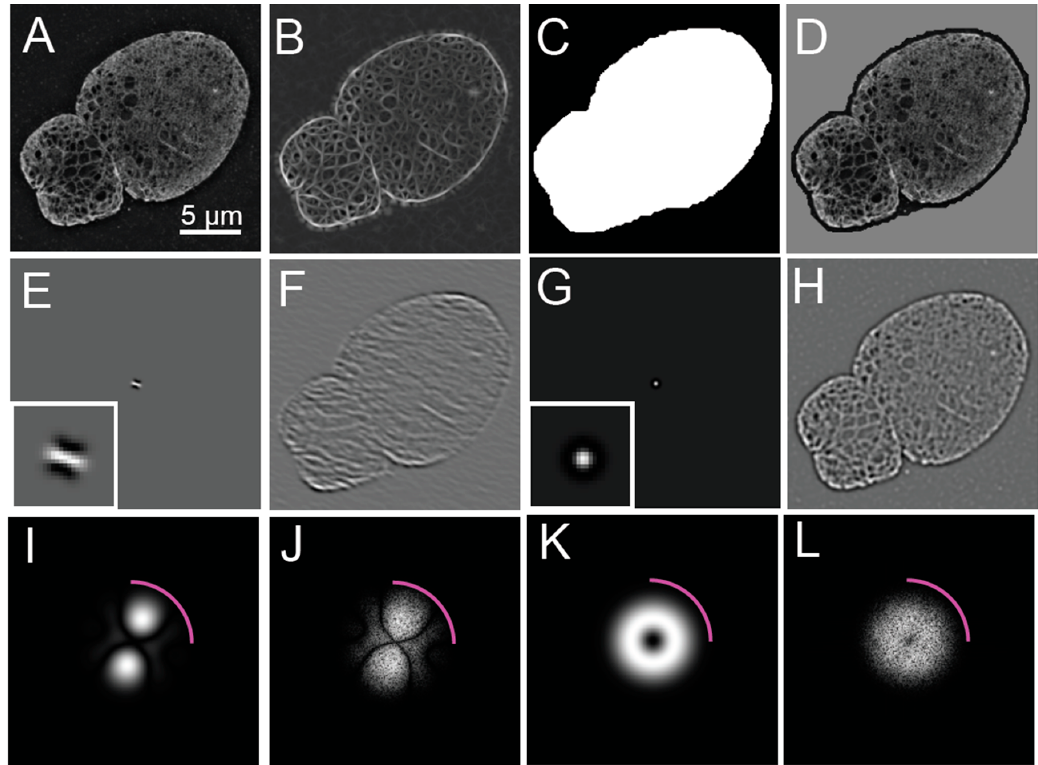
Figure 2. Steerable Filter Properties and Initial Application to a Reconstructed Image of a SIM Image of a Lmnb1 − / − MEF. ( A ) For reference, the reconstructed 3D-SIM image of a Lmnb1 − / − mouse embryonic fibroblast (MEF) nucleus is redisplayed from Figure 1C. ( B ) The image obtained after a steerable filter bank was applied to the image shown in (A). From the steerable filter response, a nucleus mask ( C ) was created by thresholding and morphological processing. To demonstrate that the nucleus was contained within the mask, the multiplicative product ( D ) of the reconstructed image (A) in the binary mask (C) is shown. To illustrate the process in more detail, a steerable filter orientated at 140 degrees ( E ) is shown in the image domain with an inset showing the filter magnified by five times. The grey background indicates zero-level, while black indicates the negative portion of the filter. When the steerable filter (E) was applied to the reconstructed image of the Lmnb1 − / − MEF nucleus (A), the response ( F ) indicates how well the image matches the oriented filter. Steerable filters were averaged over all orientation angles to produce the average filter ( G ) with the inset showing the averaged filter magnified by five times. The grey background indicates zero-level while black indicates the negative portion of the filter. The averaged filter (G) was applied to the reconstructed image (A) to produce an averaged steerable response ( H ), enhancing the areas matching the scale selective bandpass of the averaged filter. Two-dimensional Fourier transforms (2DFT) of (E), (F), (G), and (H) are shown in ( I ), ( J ), ( K ), and ( L ), respectively. The 2DFT of the oriented filter (I) and averaged filter (K) shows the scale and orientation selectivity in the Fourier domain. In the Fourier domain, the application of the oriented and averaged filters is a pointwise product of (I) and Figure 1D, resulting in (J) a pixel-wise product of (K), and Figure 1D, resulting in (L) due to the convolution theorem. Magenta arcs in (I-L) indicate widefield resolution cut-off limit shown at 250 nm as shown in in Figure 1. Fourier Transforms are shown as a log (magnitude+1). The white scale bar indicates 5 micrometers.